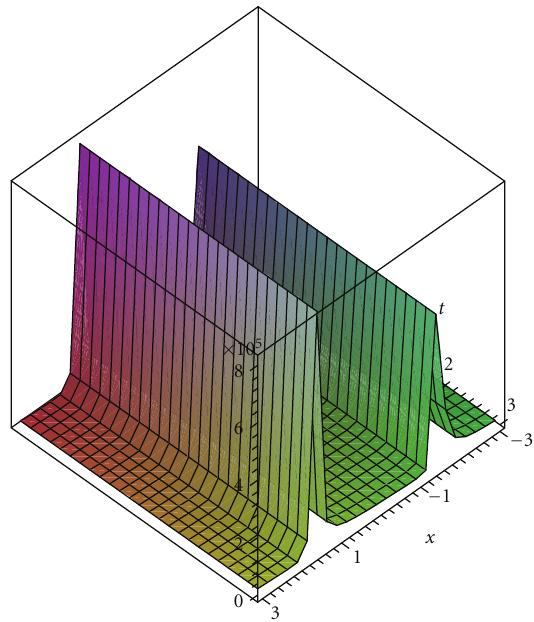
Figure 1: Graph of (31) for 𝑔 4 = 1 , 𝛼 = 𝜇 = 1 , 𝑎 4 = tan 𝑥 , 𝑎 6 = −1